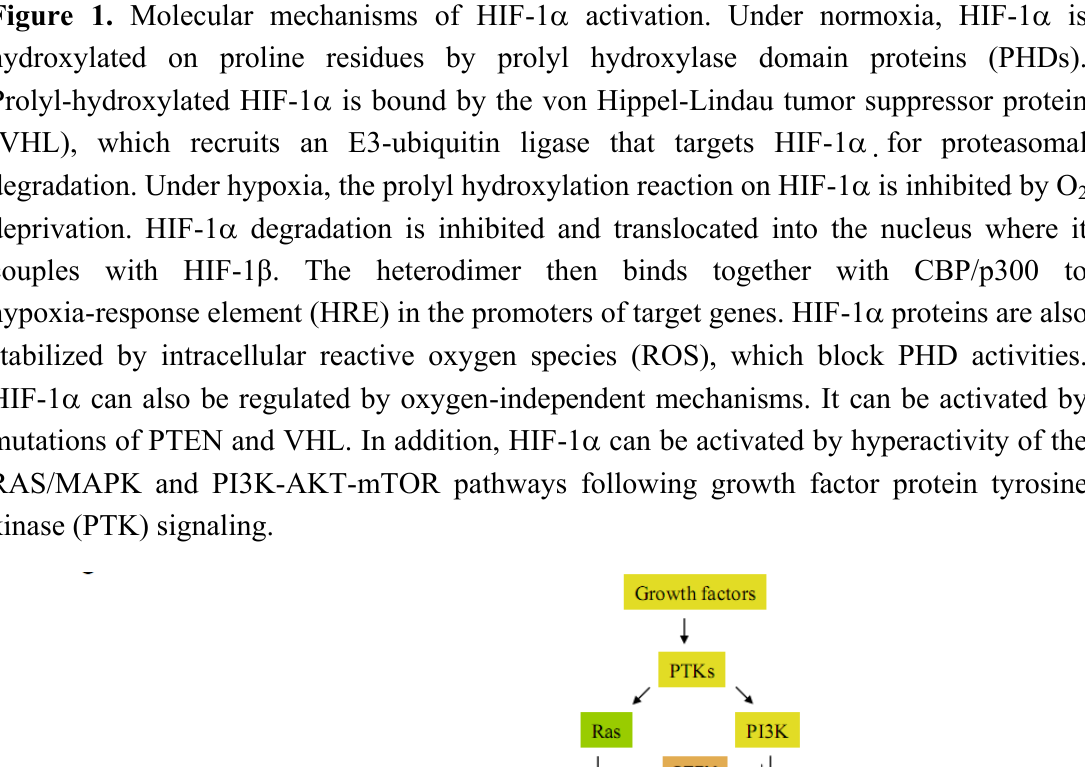
Figure 1. Molecular mechanisms of HIF-1  activation. Under normoxia, HIF-1  is hydroxylated on proline residues by prolyl hydroxylase domain proteins